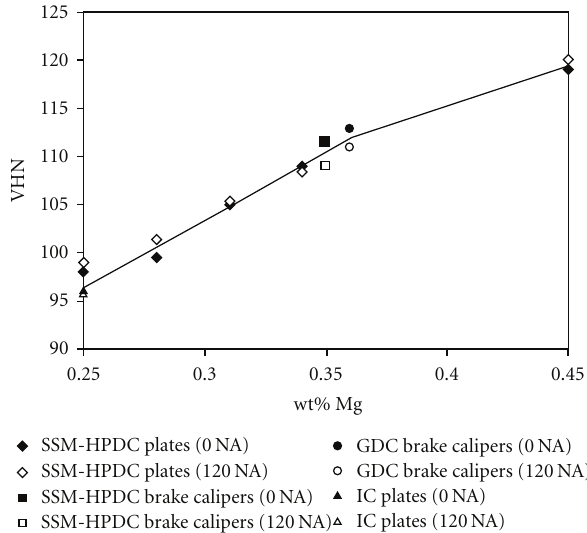
Figure 6: T6 (540 ◦ C-1 h, 0 or 120h NA, 180 ◦ C-4 h) hardness values as a function of the Mg-content of A356 produced using di ff erent casting techniques.